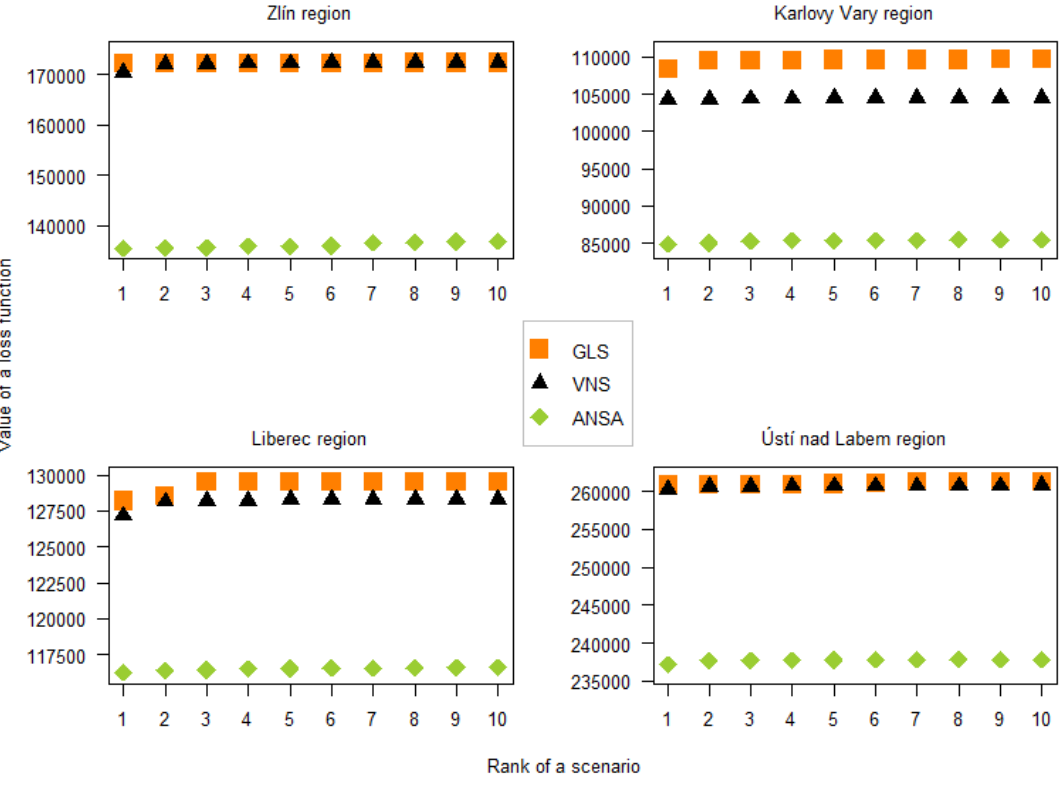
Figure 8. Values of the ten most critical scenarios determined by all the algorithms for ten concurrently interrupted